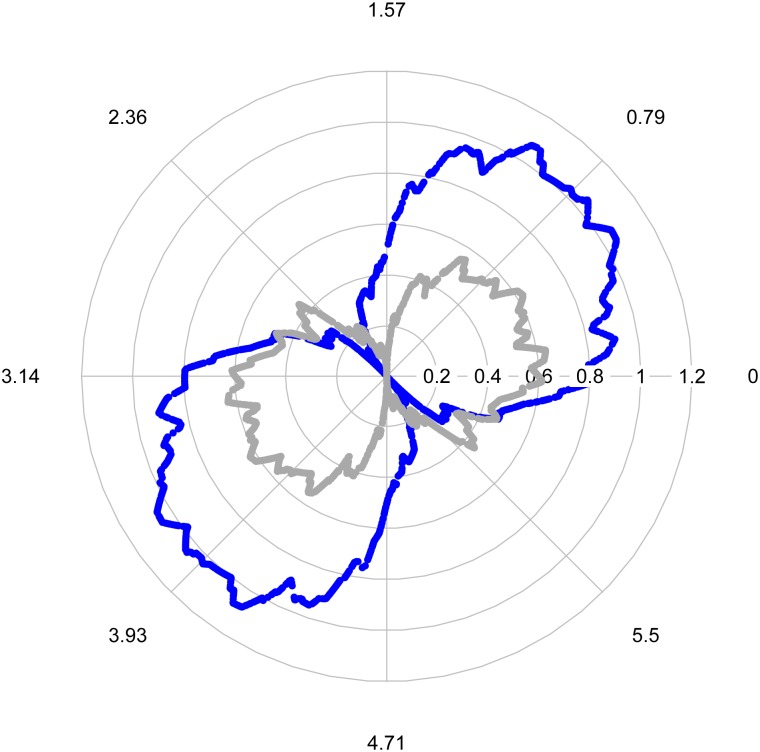
Polar plot (in radians) of the magnitude of mX(μ, a).Grey line: μ = (2.2, 8) and Blue line: μ = (2, 7.5).